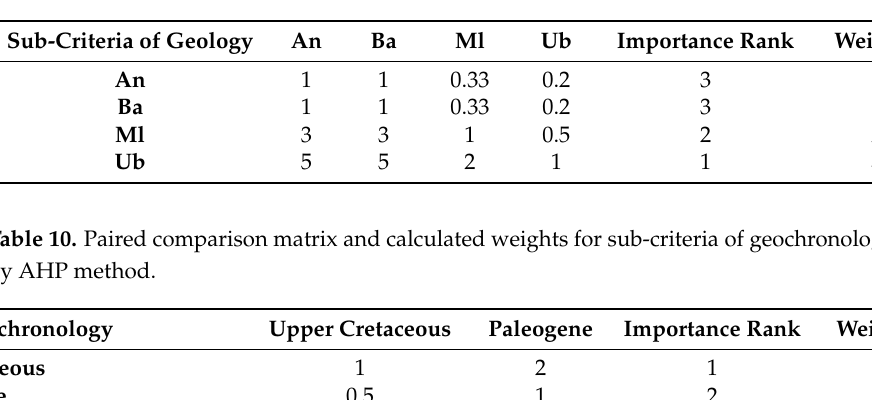
Table 9. Paired comparison matrix and calculated weights for sub-criteria of geology criteria by AHP method.